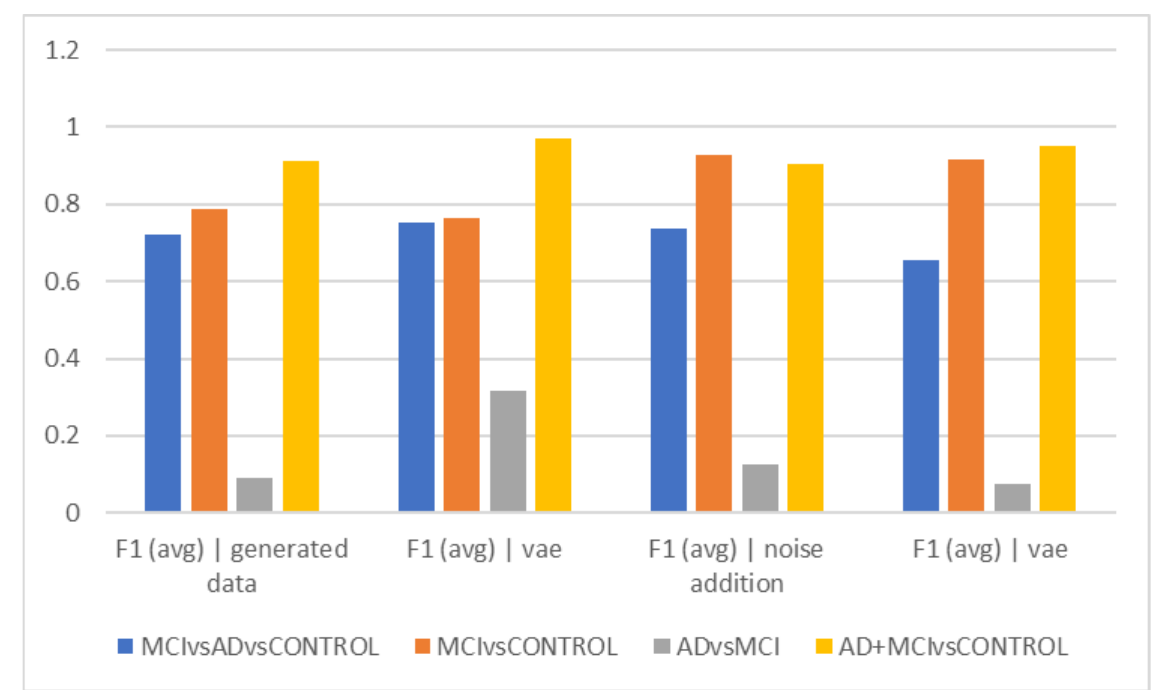
Figure 5. Comparison of results for a period of 10 s (F1).